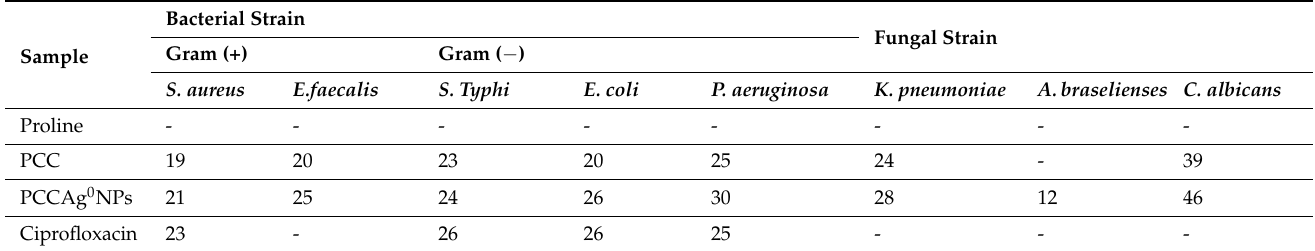
Table 9. Antimicrobial activities of the crystals expressed in inhibition